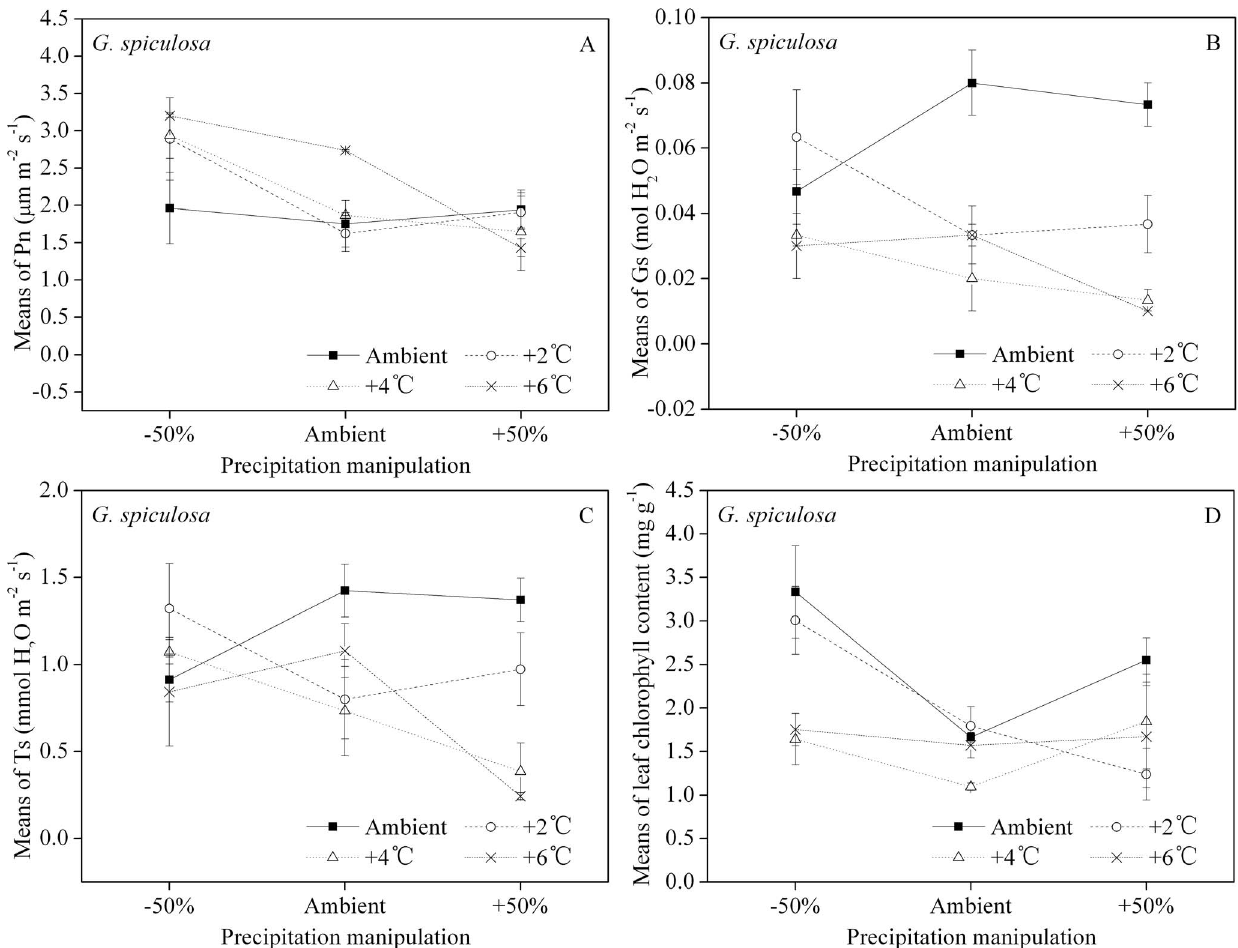
Figure 5. Main effect of precipitation manipulation on G.spiculosa ’s leaf net photosynthetic rate (Pn, A), interactions of temperature and precipitation manipulations on leaf stomatal conductance (Gs, B), leaf transpiration rate (Ts, C) and leaf chlorophyll content (D), respectively. Different letters shared by the bars indicate significant differences ( p , 0.05) between precipitation treatments. The error bars represent means 6 1 standard error.